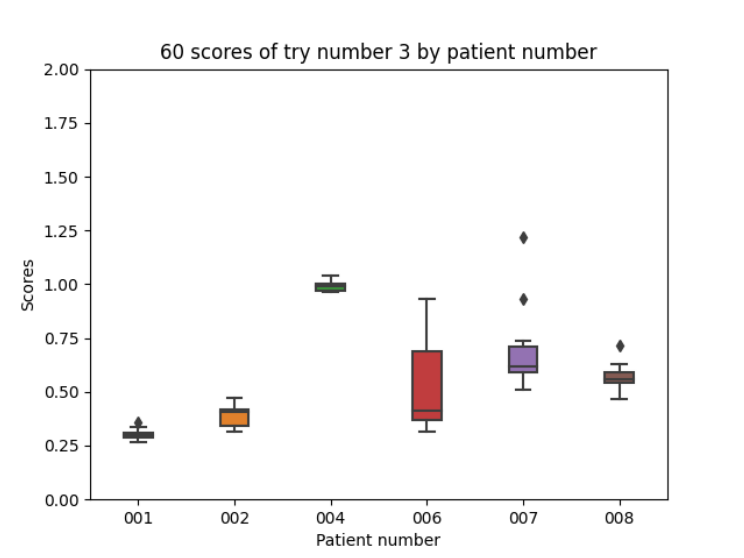
Figure 14. Experiment 3 boxplot scores, from 10 executions for each patient and